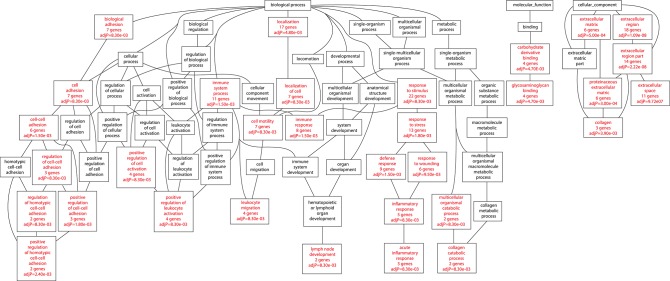
Biological processes impacted by up-regulated genes in animals infected with strain 48 compared with animals infected with strain 48V at day 21 postinfection.